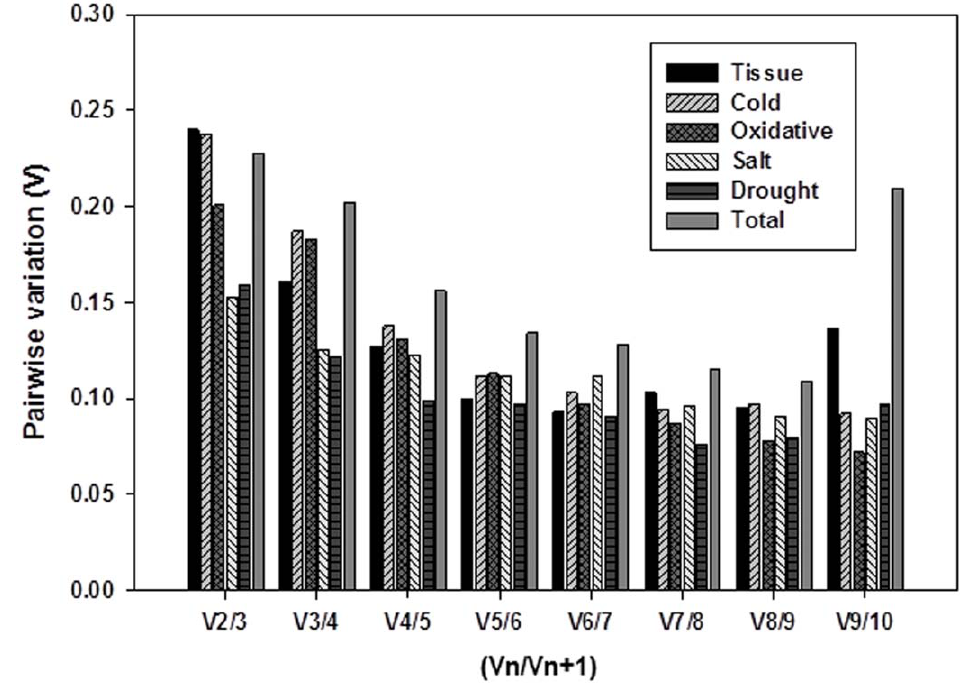
Figure 3. Pairwise variation ( V ) analysis of the candidate reference genes. The geNorm software was used to analyze the pairwise variation ( Vn/Vn + 1 ) between the normalization factors NF n and NF n + 1 in order to determine the optimal number of reference genes required for RT-qPCR data normalization.